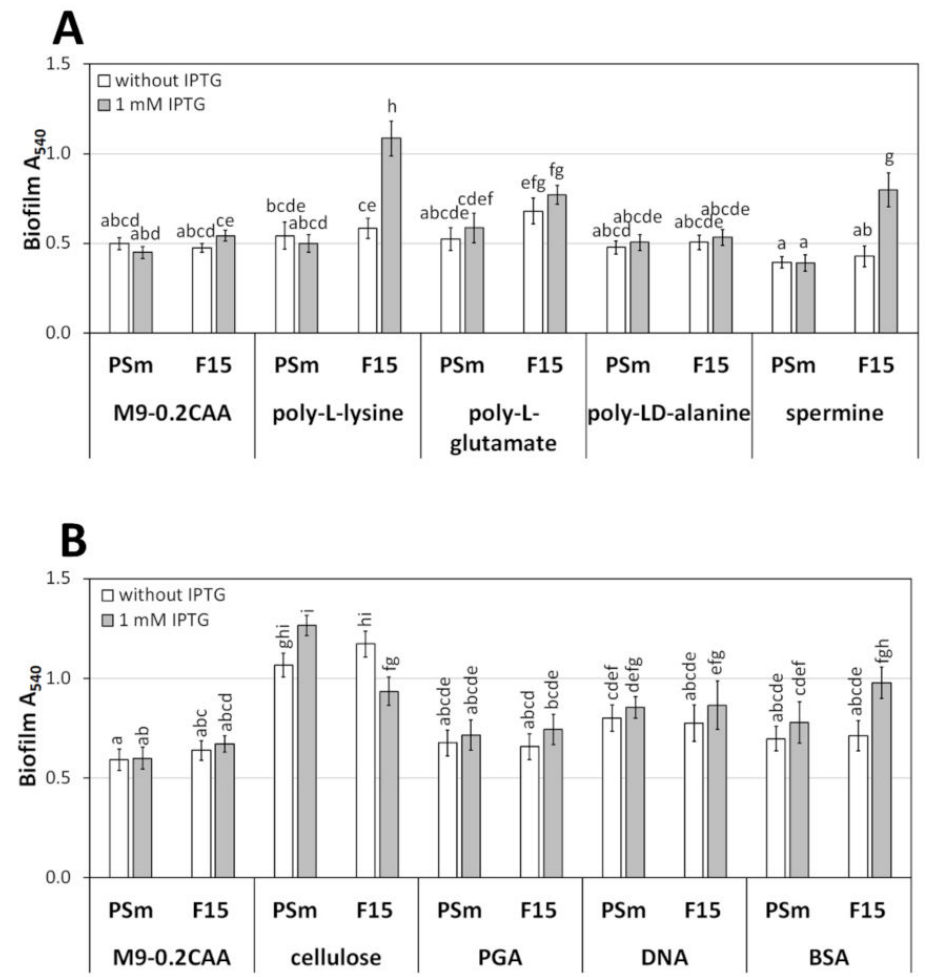
Figure 7. The biofilm of P. putida in M9-0.2CAA supplemented with biopolymers. ( A ) The biofilm of P. putida strains PSm and F15 in the M9-0.2CAA medium supplemented with 0.4 mg/mL of poly-L-lysine (pK), 0.4 mg/mL of poly-L-glutamate (pE), 1.4 mg/mL of poly-LD-alanine (pA), or 0.4 mg/mL of spermine. ( B ) The biofilm of P. putida in M9-0.2CAA supplemented with water-soluble Na-cellulose, poly-galacturonic acid (PGA), salmon sperm DNA, and bovine serum albumin (BSA). The arithmetical averages of at least three independent measurement sets are shown. Brackets show the 95% confidence intervals, and the homogenous groups are shown above columns by the lower-case letters. Identical letters denote non-significant differences ( p ≥ 0.05) between averages of